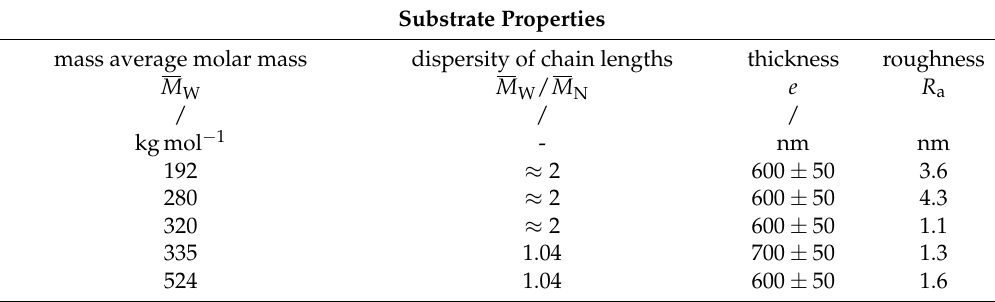
Table 1. Substrate properties used in this